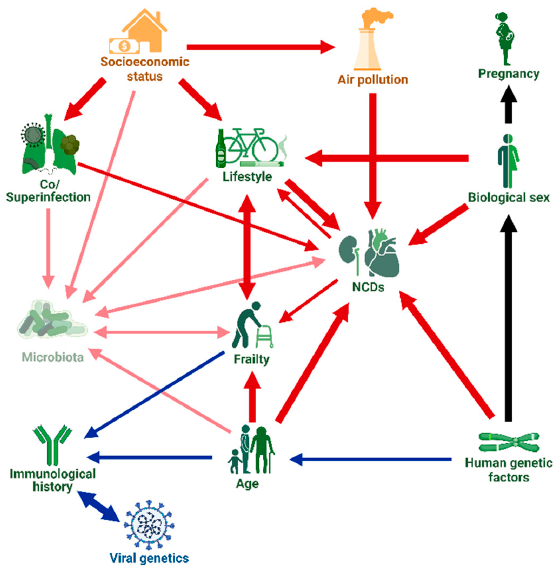
Figure 1. The network of interactions between identified and proposed risk factors of severe COVID-19. Host (green), viral (blue) and environmental (yellow) factors are connected by arrows indicating three types of interactions between the factors: some factors might modulate the effect of other factors (blue arrows), e.g., advanced age shortens the duration of effective adaptive immune responses; some interactions may affect the occurrence of factors (red arrows), e.g., lifestyle choices influence the likelihood of certain comorbidities; finally, some factors act as the major determinant of another (black arrows), e.g., biological sex determines the possibility of pregnancy, and sex itself is genetically determined in humans. The width of the arrows indicates the perceived magnitude of these effects. The pictogram of microbiota alterations is faded out to illustrate the uncertainty of its causal role in the development of severe COVID-19. The figure was created with BioRender.com.